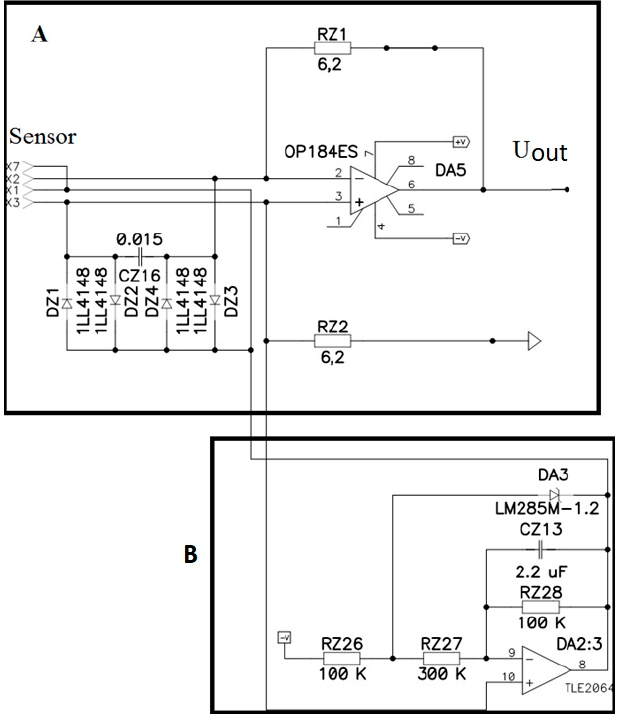
Figure 4. Electronic circuit for forming the voltage between the electrodes ( B ) and the electronic circuit for forming output signal ( A ).